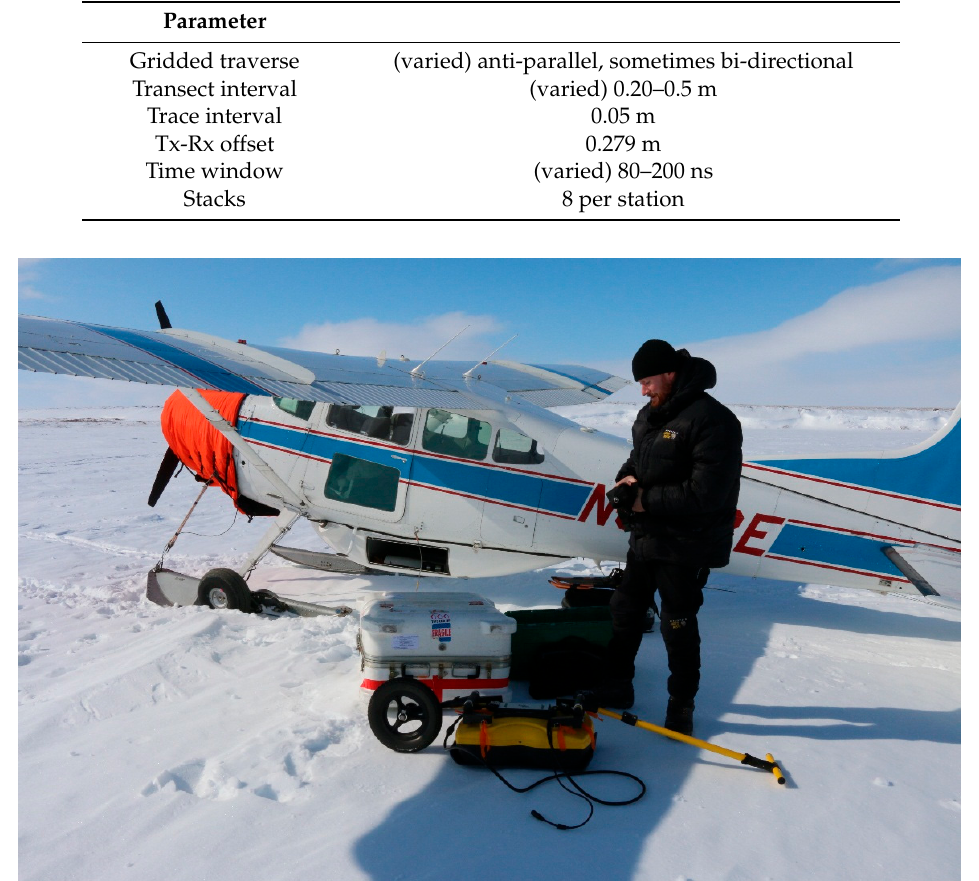
Table 2. Instrument and survey parameters.